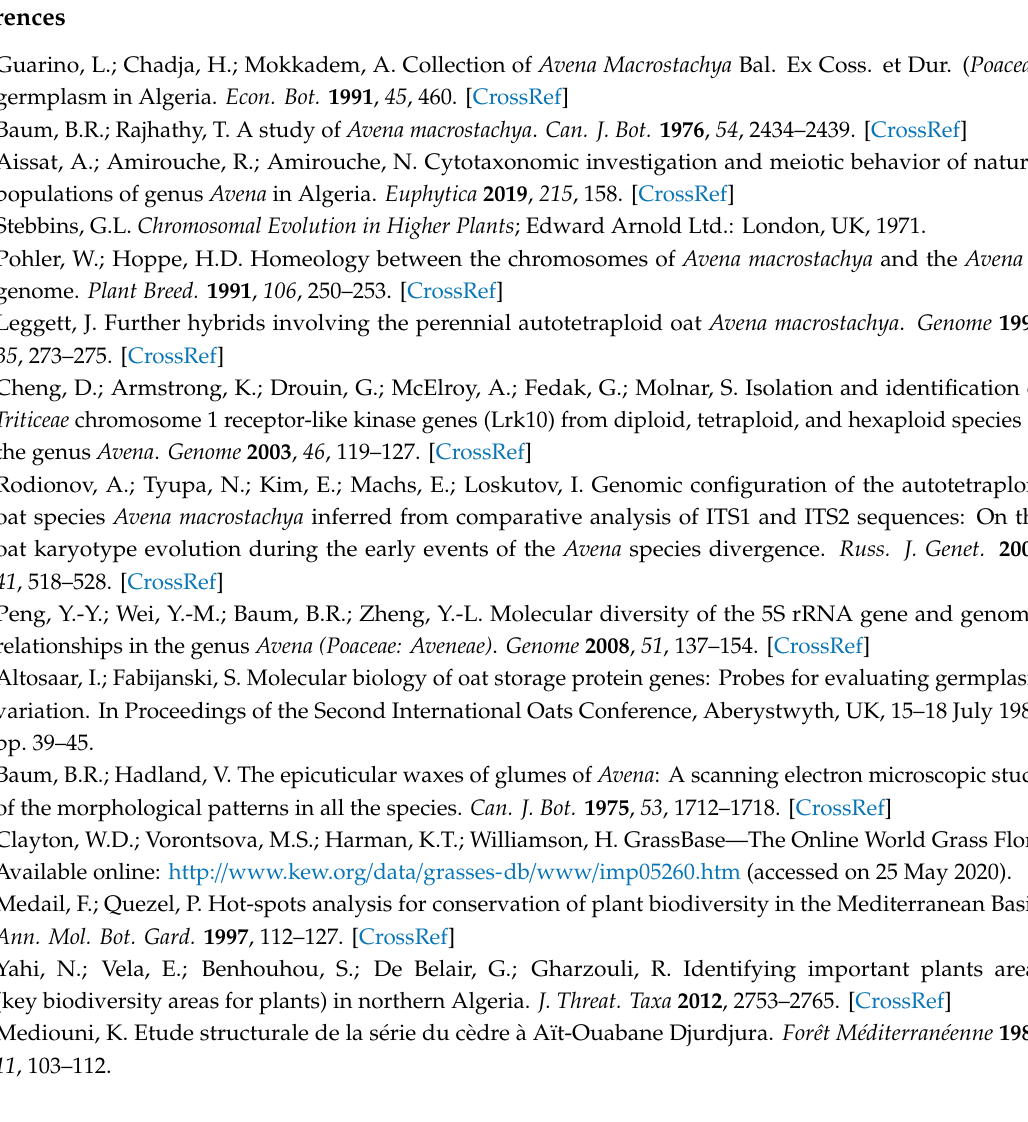
Table S1: The resources of accessions of Avena macrostachya in ex situ living collections and